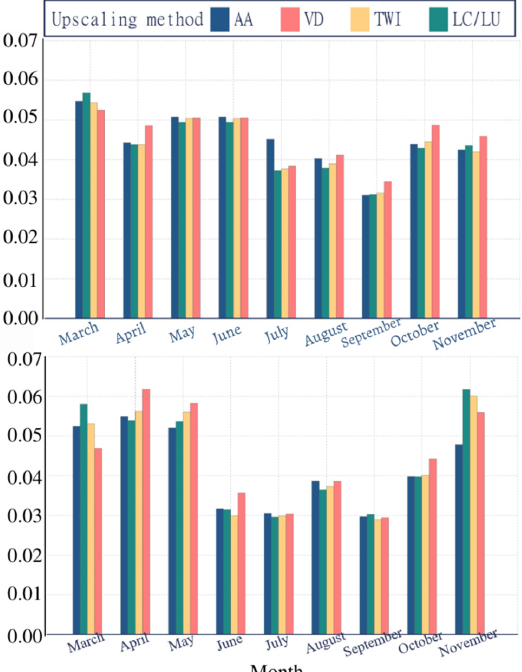
Figure 8. Temporal variation of monthly ubRMSD values (in m 3 .m − 3 ) for SMAP L2SMP_E AM overpass ( top ) and PM overpass ( bottom ) observations and in situ measurements derived from the upscaling techniques based on the Arithmetic Average (AA), Voronoi Diagram (VD), Topographic Wetness Index (T), and Land Cover (LC).